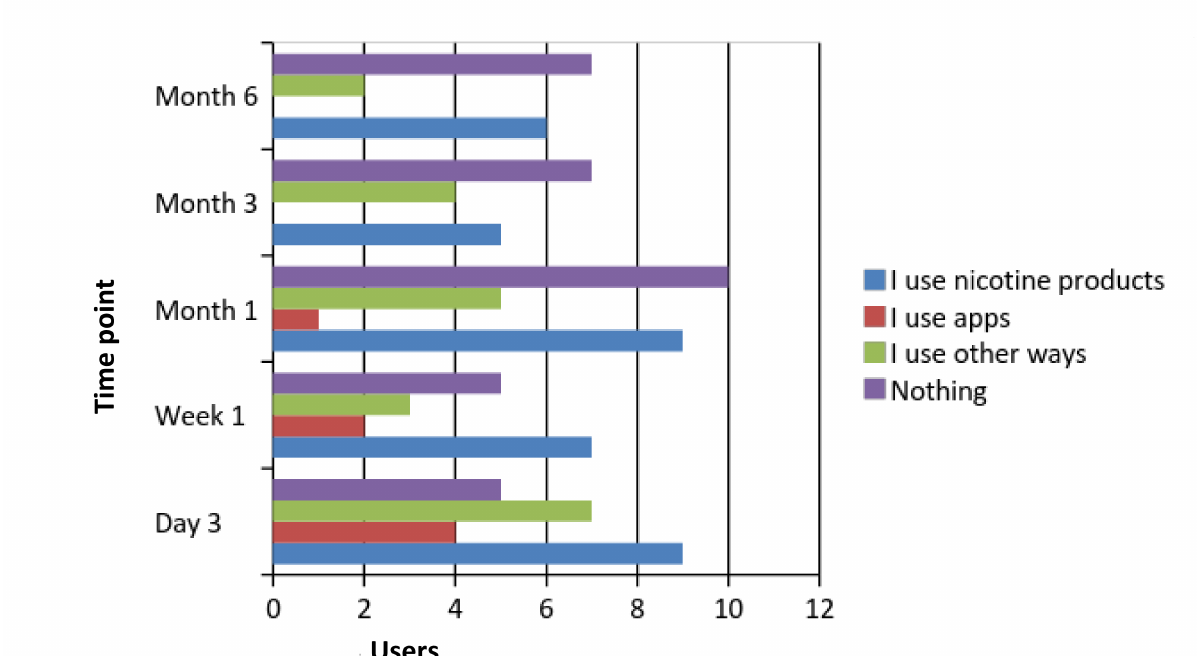
Figure 4. Fidelity responses of the comparison group detailing whether they used additional